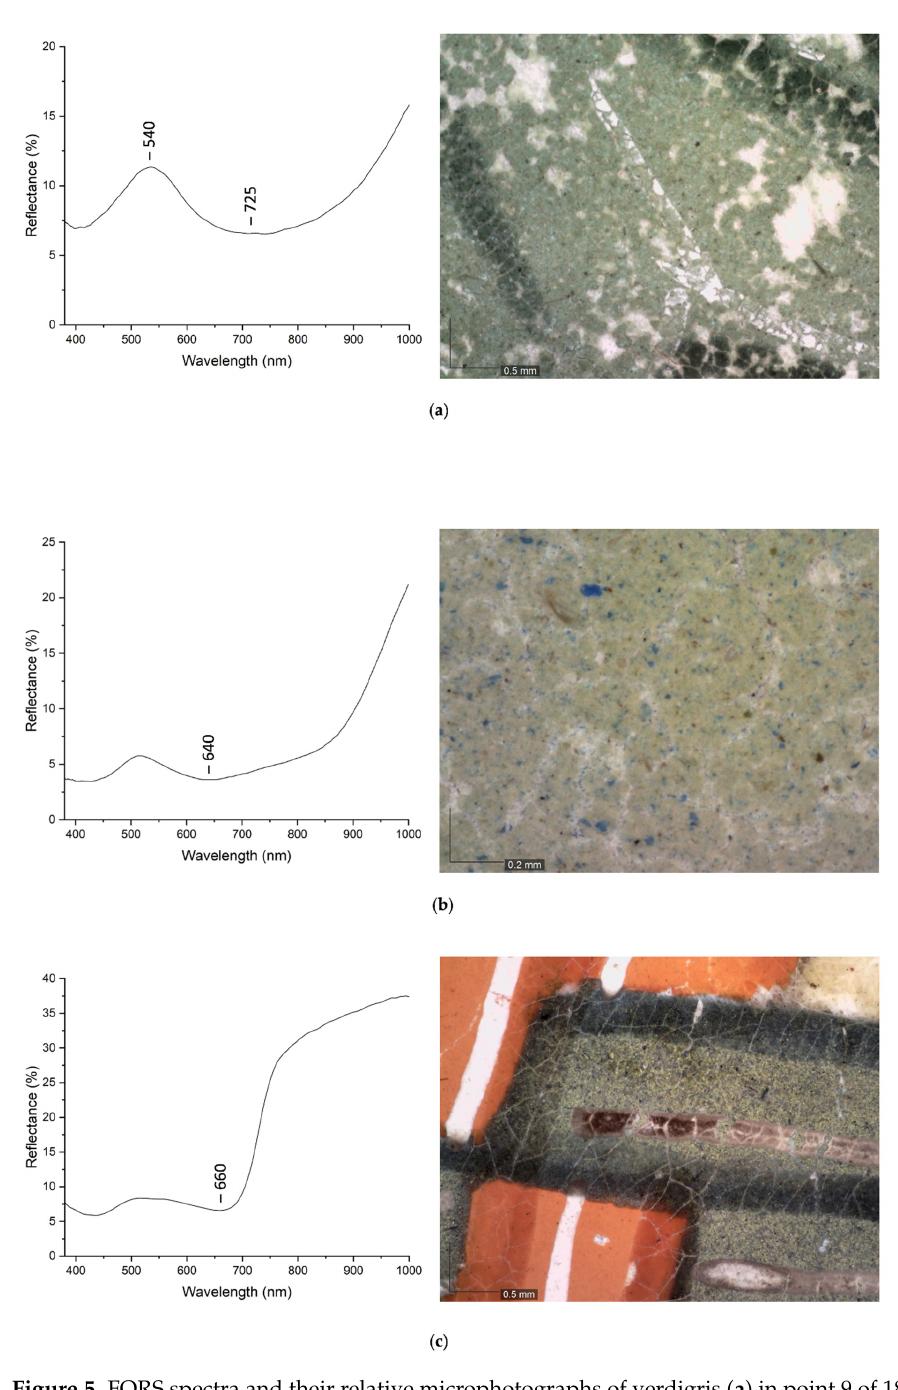
Figure 5. FORS spectra and their relative microphotographs of verdigris ( a ) in point 9 of 18r, azurite and yellow mixture ( b ) in point 12 of 18r, and vergaut ( c ) in point 14 of